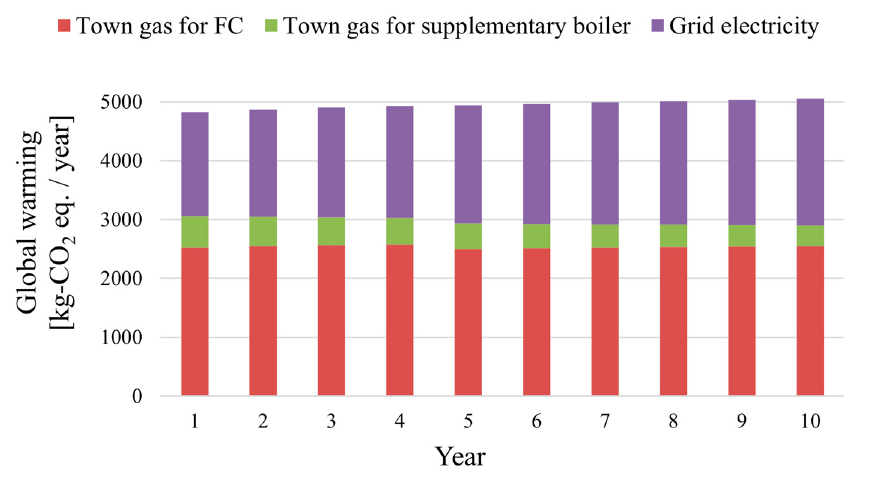
Figure 13. GWP transition per year in the utilization stage.